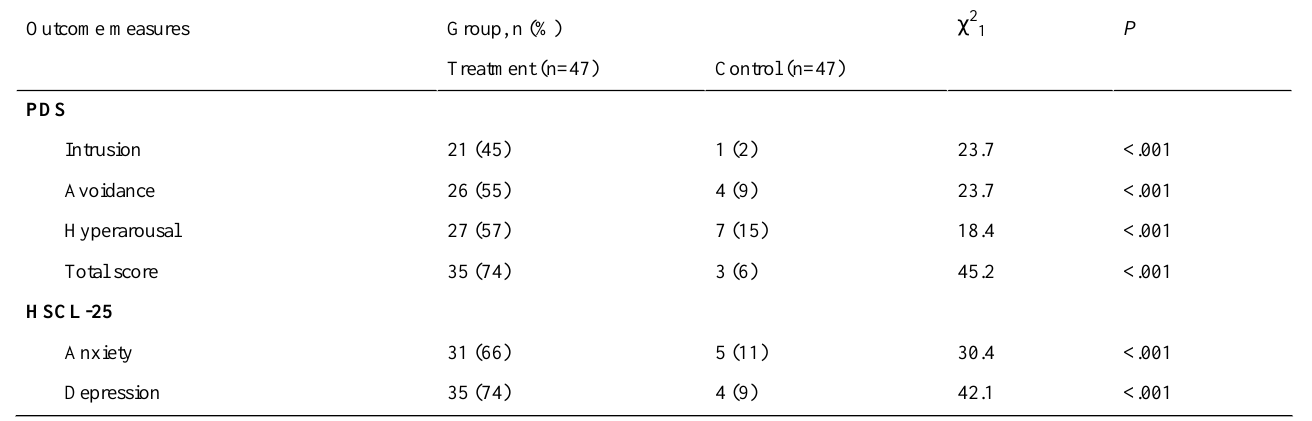
Table 4. Percentage of patients showing reliable change at